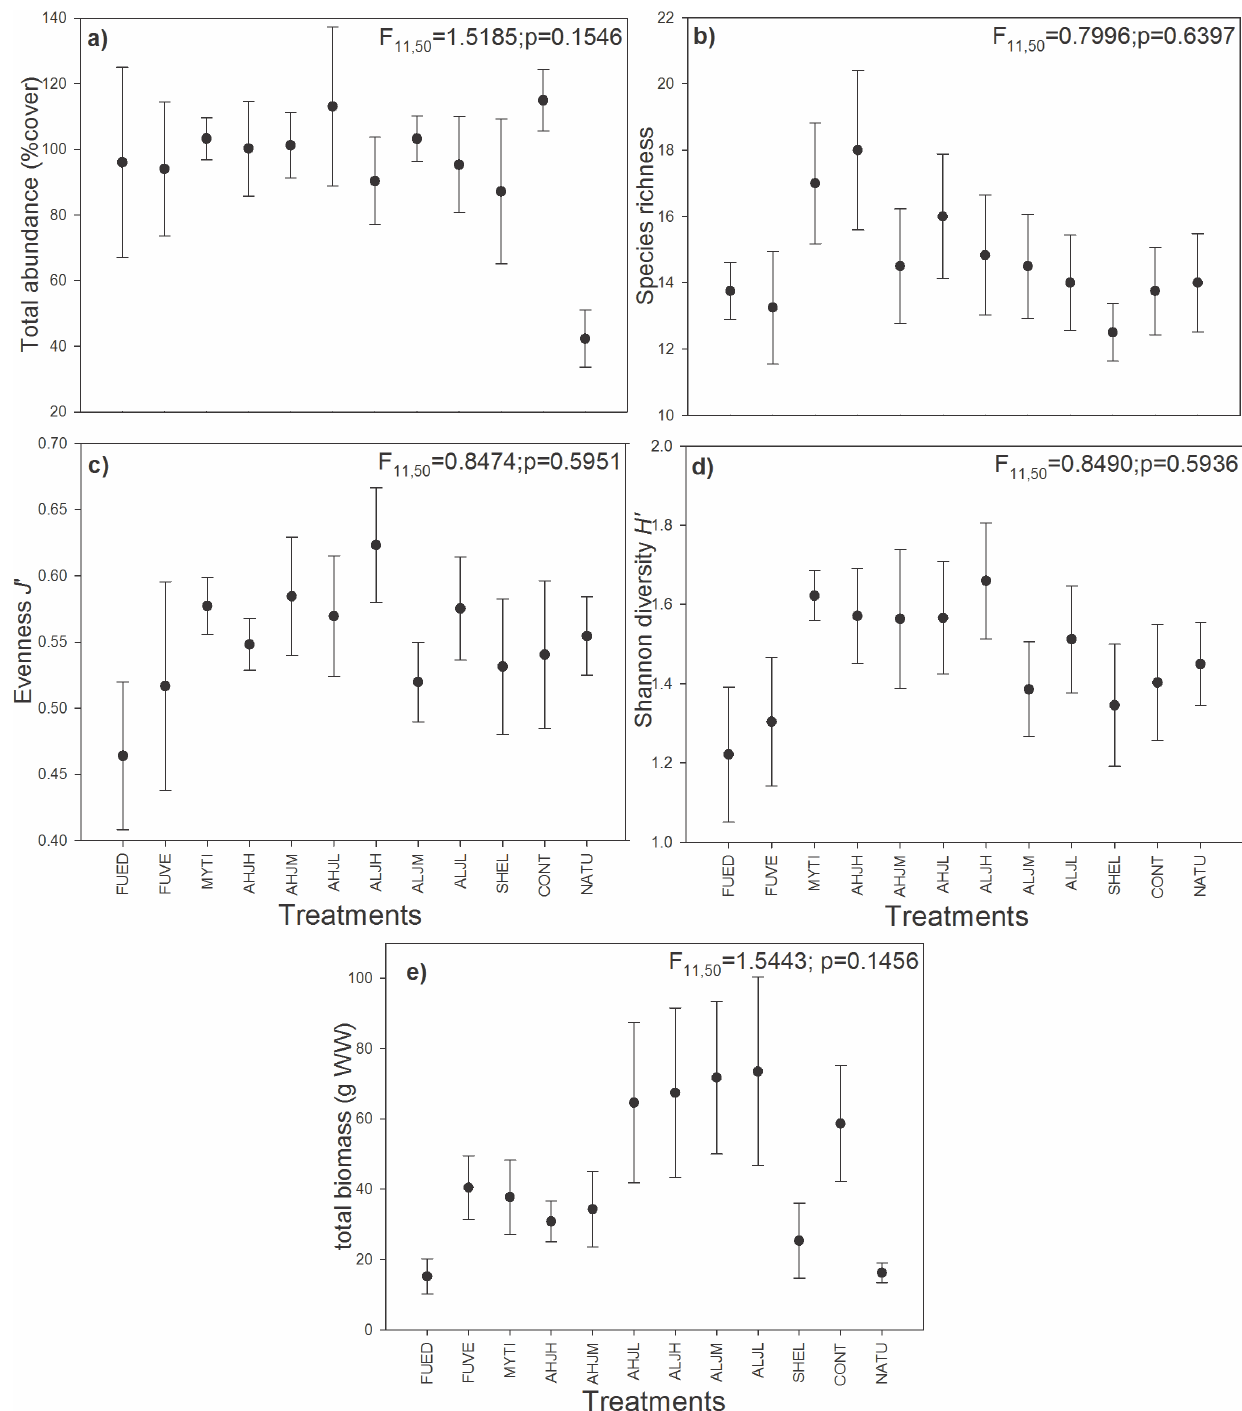
Figure 1. Average values ( ± SE) of a) total abundance (% cover), b) species richness, c) evenness (Pielou J ’), and d) diversity index (Shannon H ’) e) in total abundance in biomass (g of Wet Weight) of associated species for each treatment. Treatments consisted of artificial assemblages with habitat-forming species having 2 levels of abundance (high, AH: 100–130 total % cover; and low, AL: 40–45% cover) and three levels of evenness J ’ values (high 6 0.097: JH; medium 6 0.75: JM; and low 6 0.55: JL) as well as monoculture treatments with 100% cover of Fucus distichus edentatus (FUED), 100% cover of Fucus vesiculosus (FUVE), 30% Mytilus spp. (mussel), and a control with 30% Mytilus spp. empty shells (shells) and a natural reference community (natural). Percentage cover data set was used here, see Methods section.